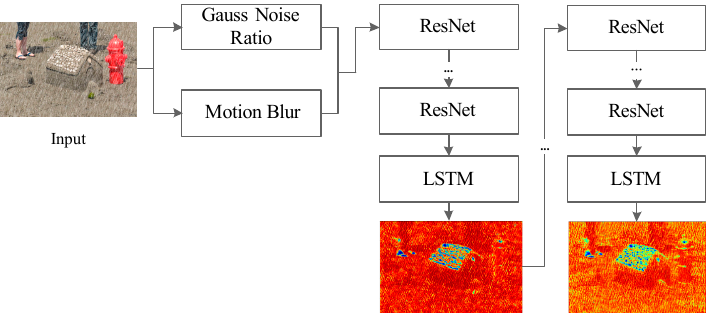
Figure 2. Architecture of the RNN.